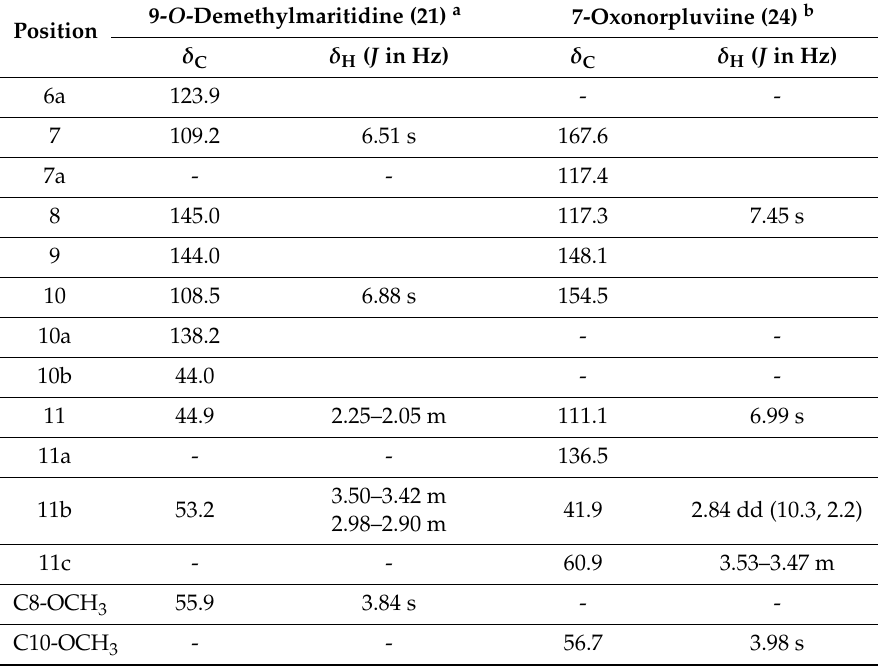
Table 2. Cytotoxic activity of alkaloidal extract of N. cv. Professor Einstein (concentration 50 µ g · mL − 1 ), and isolated Amaryllidaceae alkaloids 1 , 2 , 7 , 13 , 16 , 20 , 21 , 22 , and 23 using a single dose (concentration of 10 µ M). WST-1 metabolic activity assay was used to analyze cell growth 48 h after treatment. The results are expressed as the mean values ± SD of at least three independent experiments ( n = 3). Cells treated with 1 µ M doxorubicin served as a positive control.